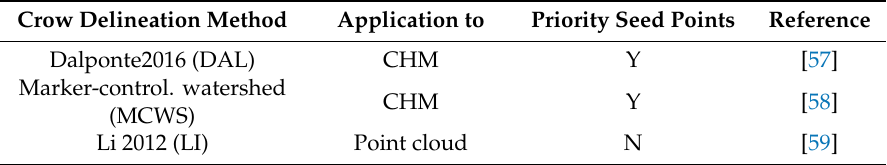
Table 4. Four automatic ITCD methods investigated in this